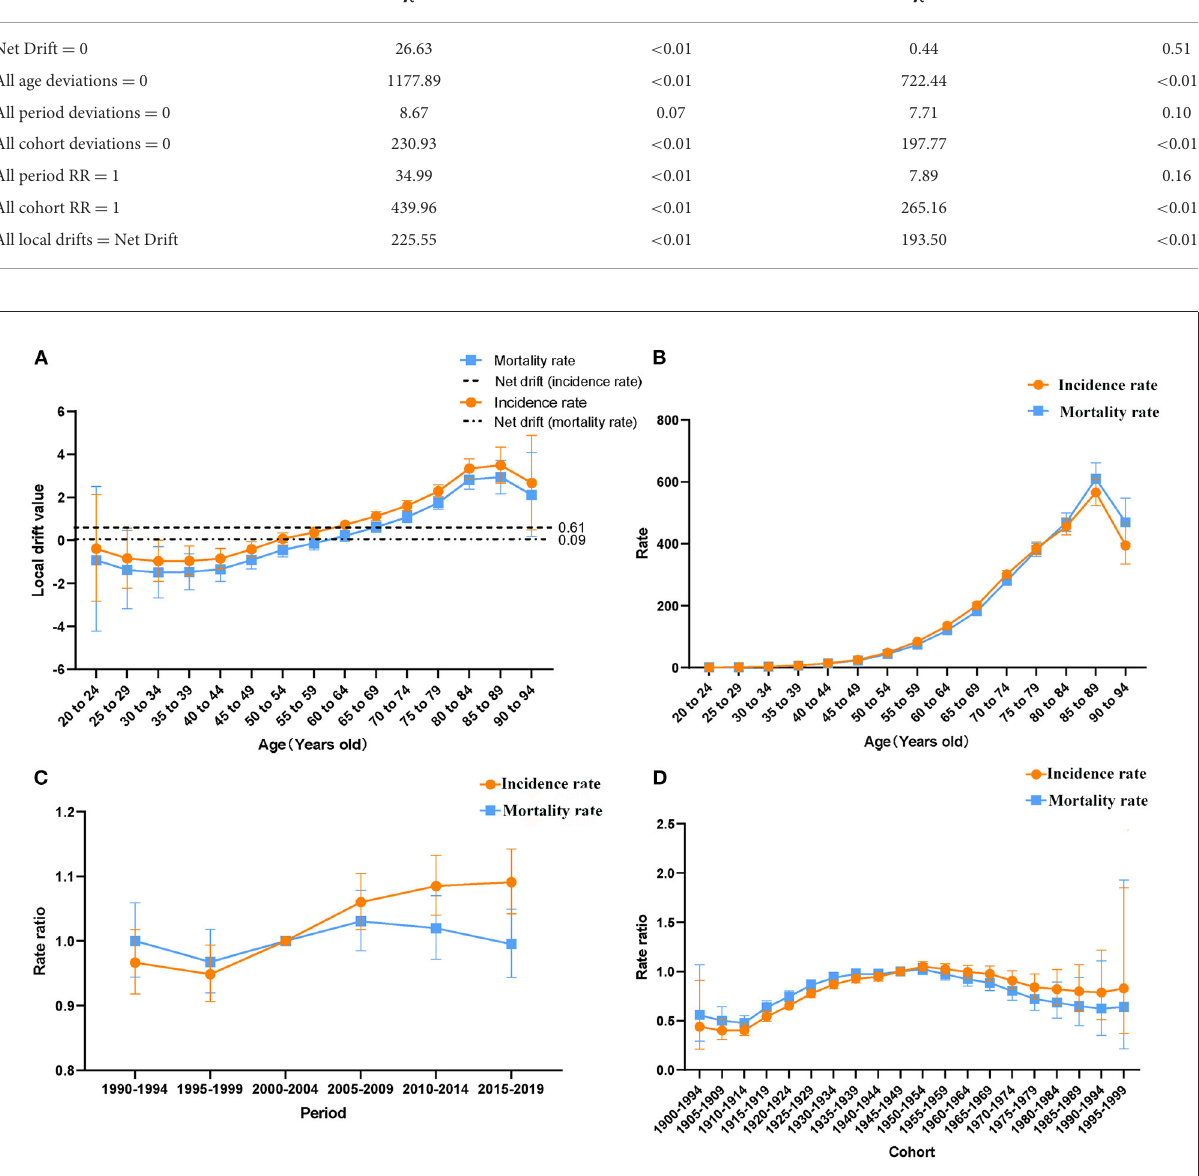
FIGURE3 Age-period-cohort model. (A) Net drift and local drifts of incidence and mortality rates of lung cancer in China from 1990 to 2019. (B) Longitudinal age curve of lung cancer incidence and mortality rates in China. (C) Period relative risks of lung cancer incidence and mortality rates in China (D) Cohort relative risks of lung cancer incidence and mortality rates in